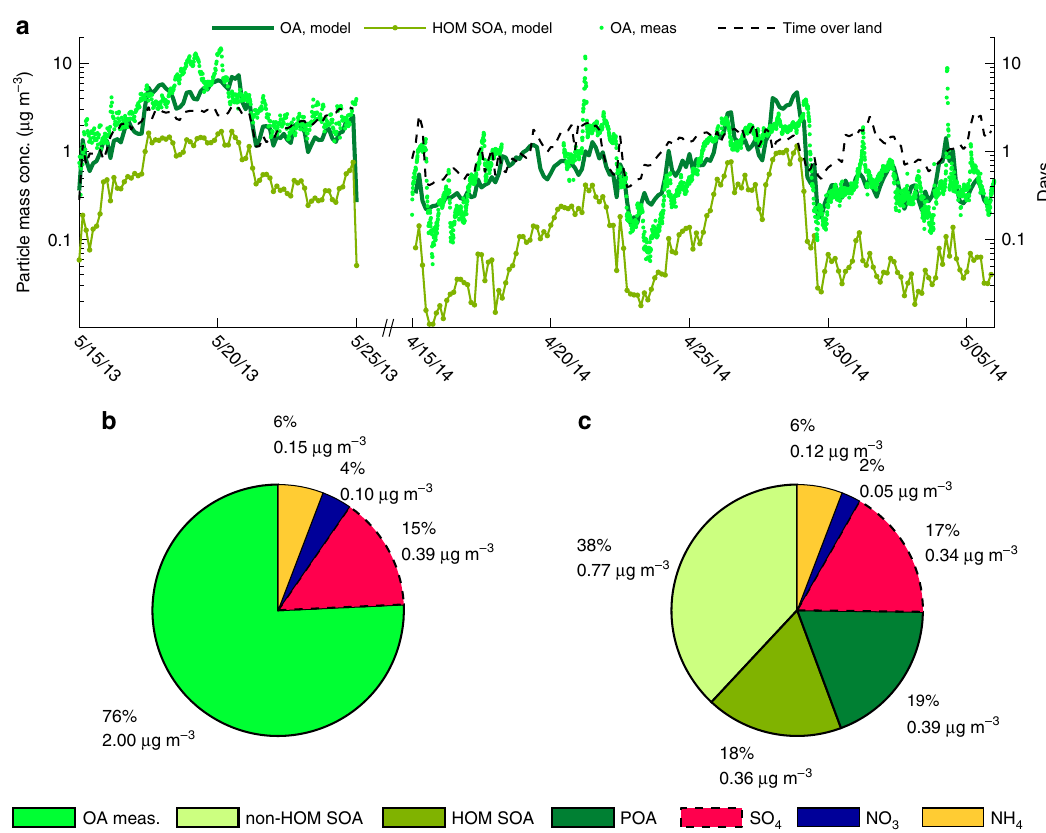
Fig. 6 Aerosol particle chemical composition. Measured and modelled particle chemical composition at the Station for Measuring Ecosystem-Atmosphere Relations II (SMEAR II) station for the periods 15 – 24 May 2013 and 15 April to 5 May 2014. Panel a shows the measured and modelled submicron organic aerosol (OA) mass concentrations. Shown are also the modelled Highly Oxygenated organic Molecule Secondary Organic Aerosol (HOM SOA) mass and the number of days the air masses have spent over land upwind SMEAR II. Panels b and c show the average measured and modelled non-refractory submicron particle chemical composition, respectively. SOA accounts for 56% and the primary organic aerosol (POA) for 19% of the modelled submicron particle mass concentration respectively. The POA mainly originates from small-scale wood combustion and road traf fi c